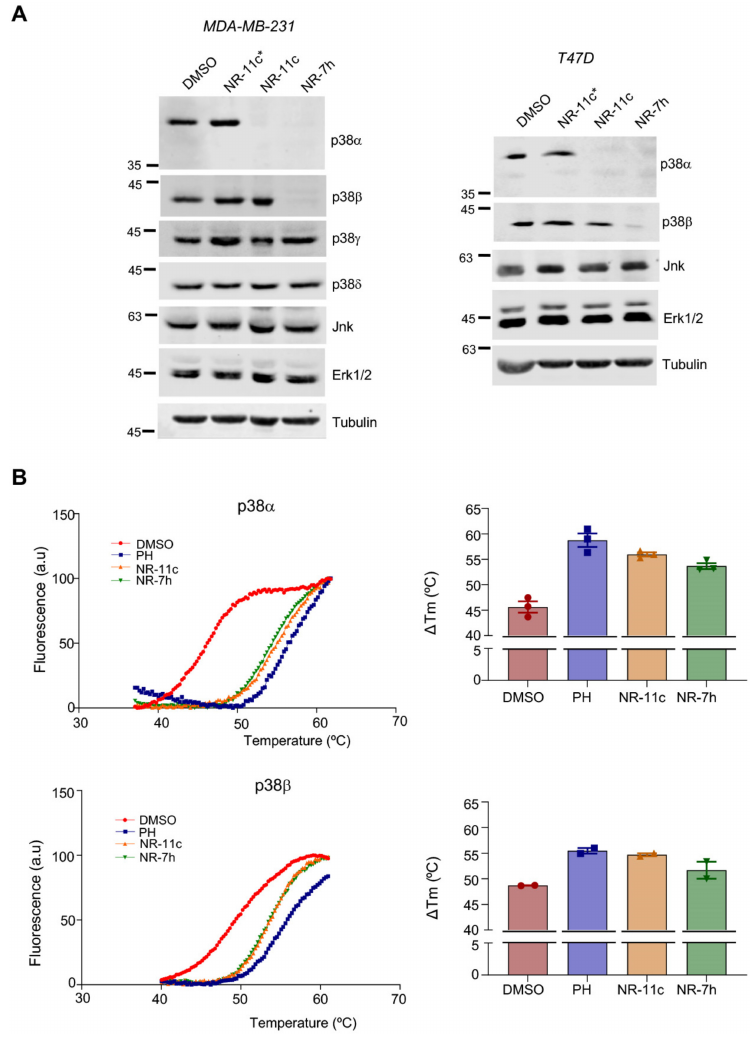
Figure 5. NR-11c specifically induces p38 α degradation. ( A ) MDA-MB-231 cell and T47D cells were treated with DMSO or the indicated PROTACS at 1 µ M for 24 h and cell lysates were then analyzed by immunoblotting using the indicated antibodies. ( B ) Purified p38 α and p38 β proteins were incubated in the presence of PH-797804 (PH), NR-11c or NR-7h at 10 µ M, and thermal shift assays were performed. Left panels show temperature-dependent fluorescent curves obtained with p38 α or p38 β . Histograms (right) represent the melting temperature values. Experiments were performed with a minimum of n = 2 biological replicates with similar results obtained each time. The uncropped blots are shown in Supplementary Materials File